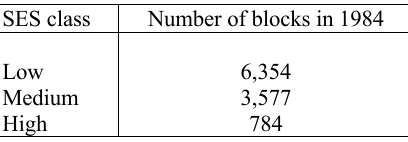
Figure 4. Block centroids count by SES in 1984.